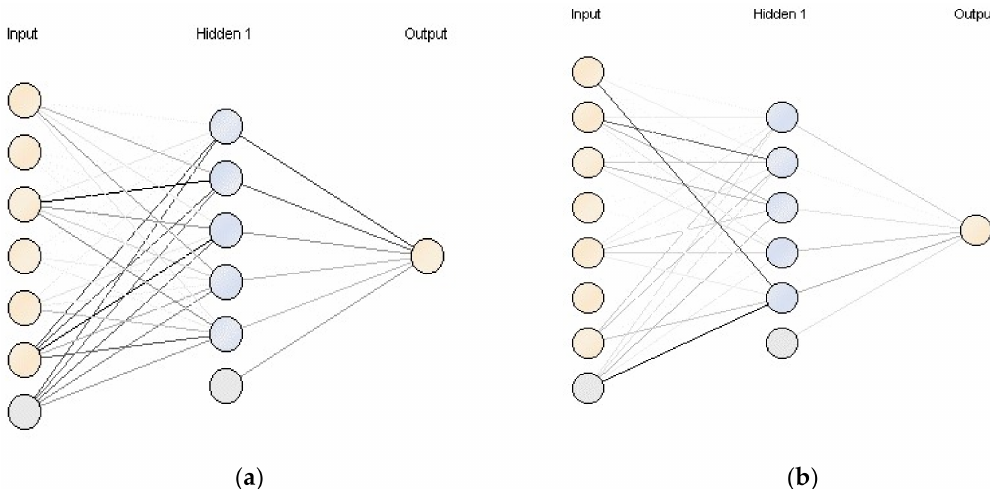
Figure 10. Neuronal networks topologies generated during the experimental analysis. ( a ) Charge neuronal network topology for all conditions. ( b ) Discharge neuronal network topology when charge time is 60